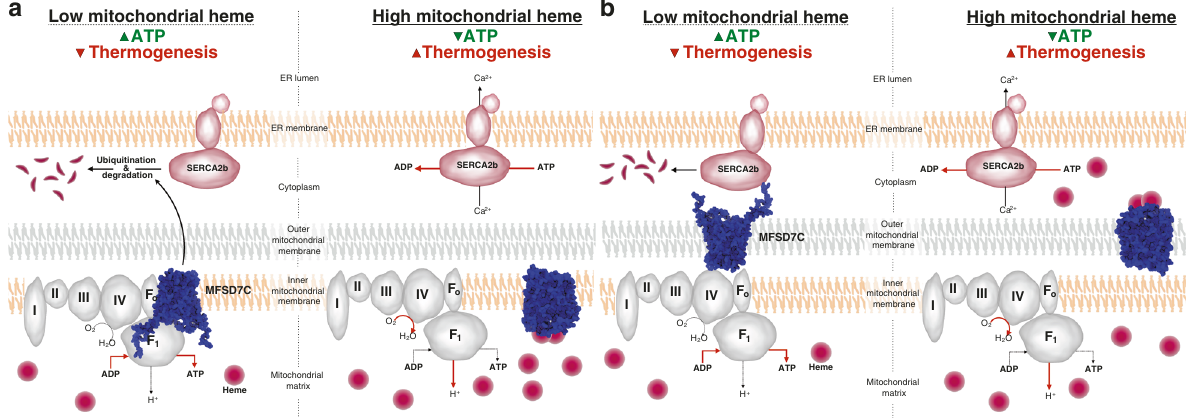
Fig. 6 Proposed MFSD7C-regulated cellular thermogenesis model. a , b Proposed models of MFSD7C regulation of mitochondrial respiration in response to heme, with MFSD7C residing in the inner ( a ) or the outer ( b ) mitochondrial membrane. When heme level is low, MFSD7C interacts with ETC components and SERCA2b, leading to SERCA2b ubiquitination and degradation and coupled mitochondrial respiration: increased ATP synthesis and reduced thermogenesis. When heme level is high, heme binding to the NTD of MFSD7C disrupts its interactions with ETC components and SERCA2b, leading to SERCA2b stabilization and uncoupled mitochondrial respiration: increased thermogenesis and reduced ATP